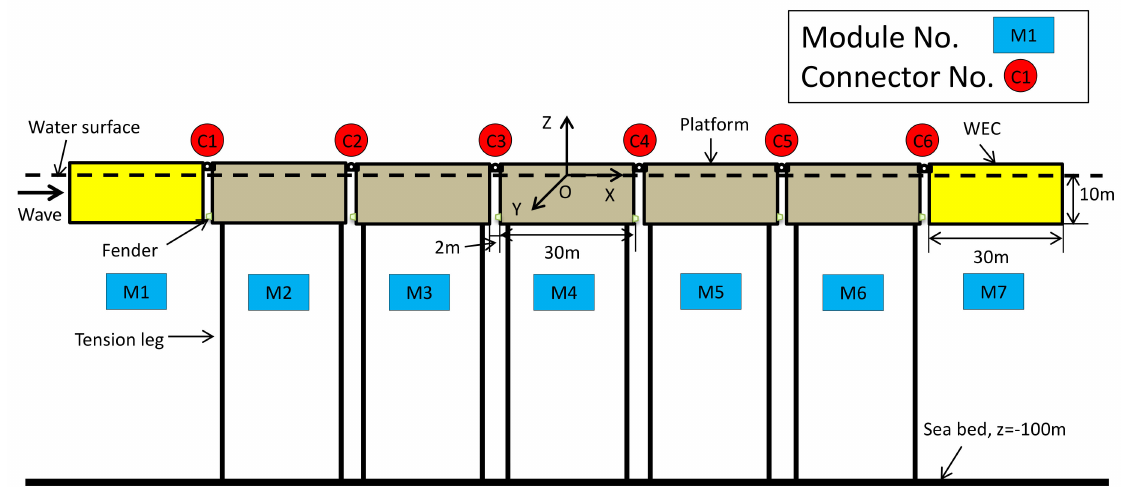
Figure 2. Sketch of the simplified 7-module MTLPW system (in side